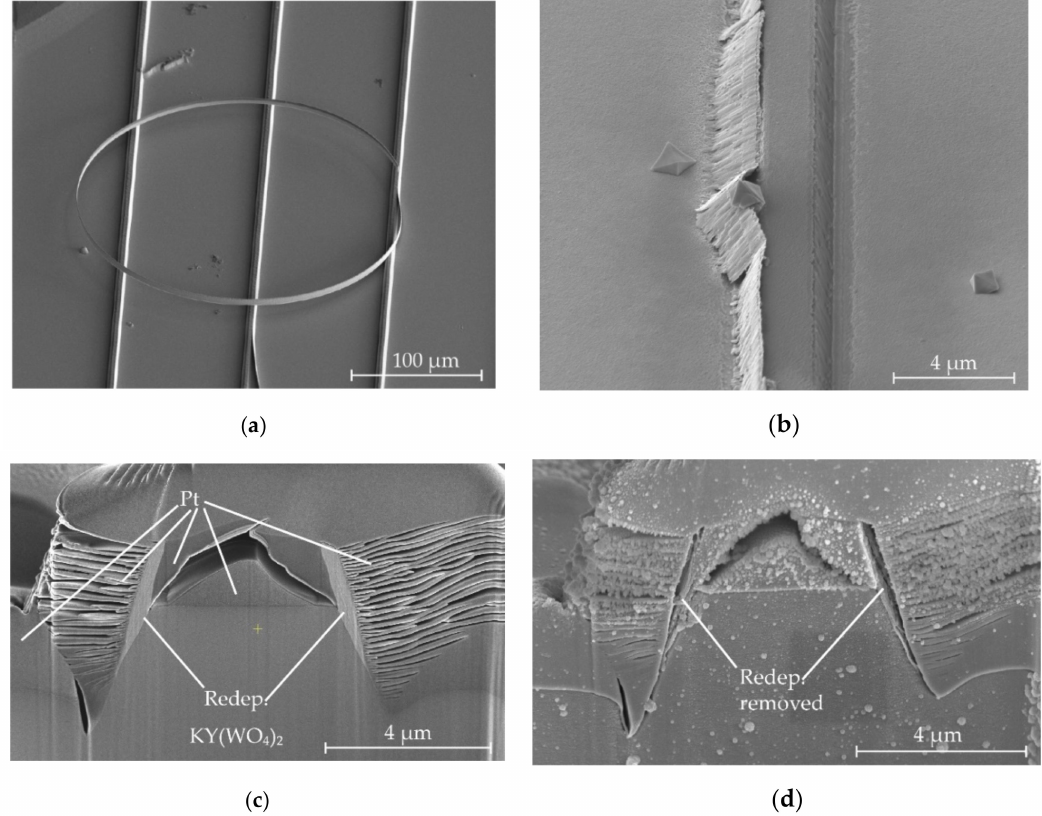
Figure 7. ( a ) A strip of sidewall redeposition that has delaminated during ultrasound cleaning and curled up due to internal shear stresses. ( b ) Sidewall redeposition that has been partially removed during an insufficiently long HCl etching step. ( c ) Cross-section of a structure with significant redeposition, covered with a thick layer of platinum. ( d ) The same cross-section after a 5 min HCl etching step. Most of the redeposited material is